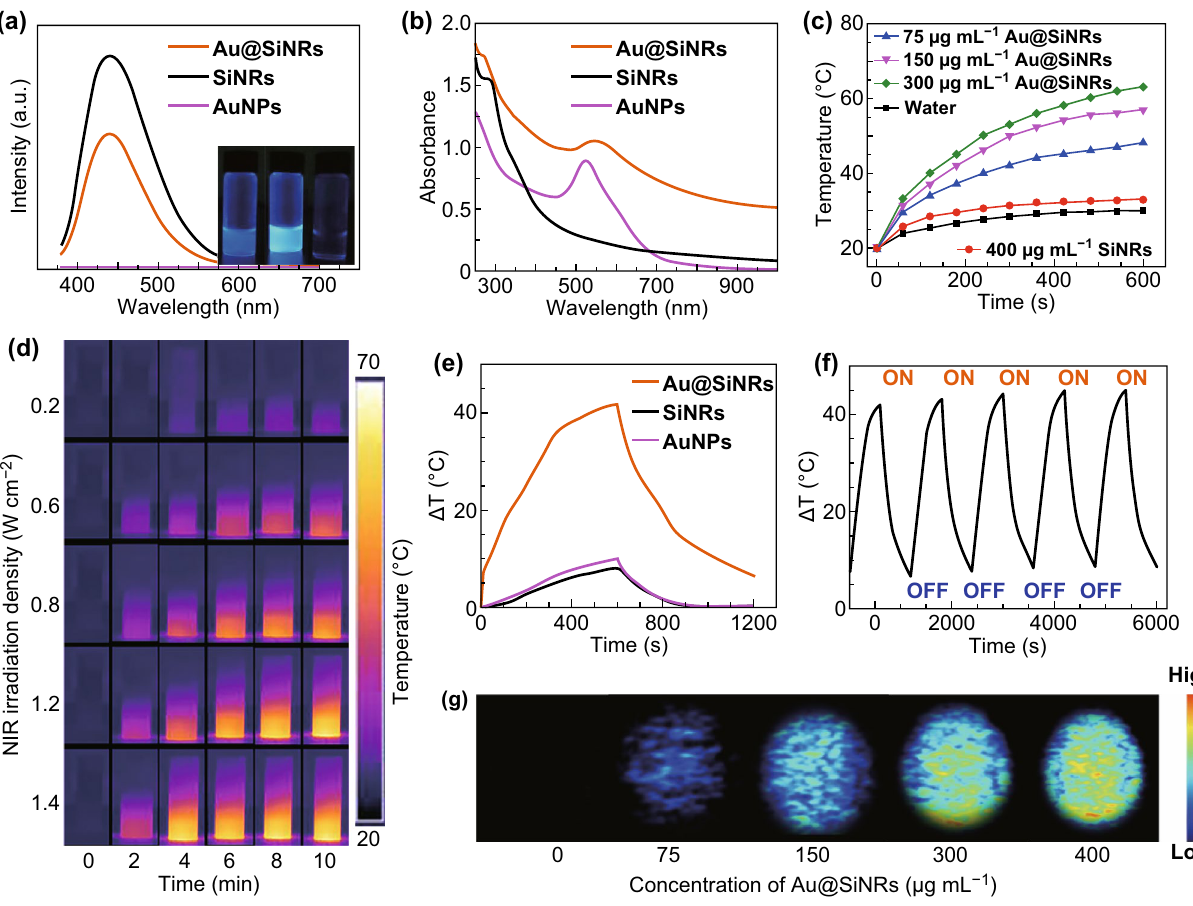
Fig. 2 Photophysical properties of Au@SiNRs. a Photoluminescence spectra (λ ex = 360 nm) and insert photographs of Au@SiNRs, SiNRs, and AuNPs from left to right. b UV–vis‑NIR absorbance spectra of Au@SiNRs (300 μg mL −1 ), SiNRs (300 μg mL −1 ), and AuNPs (0.01 M). c Heating curves of Au@SiNRs solutions with different concentrations and SiNRs aqueous suspension (400 μg mL −1 ) at 1.2 W cm −2 for 600 s. d Infrared thermal images of Au@SiNRs suspensions (300 μg mL −1 ) irradiated with 808 nm laser at a variety of power densities for 0–10 min. e Heating–cooling curves of Au@SiNRs (300 μg mL −1 ), SiNRs (300 μg mL −1 ), and AuNPs (0.01 M). f The five‑cycle photothermal profiles